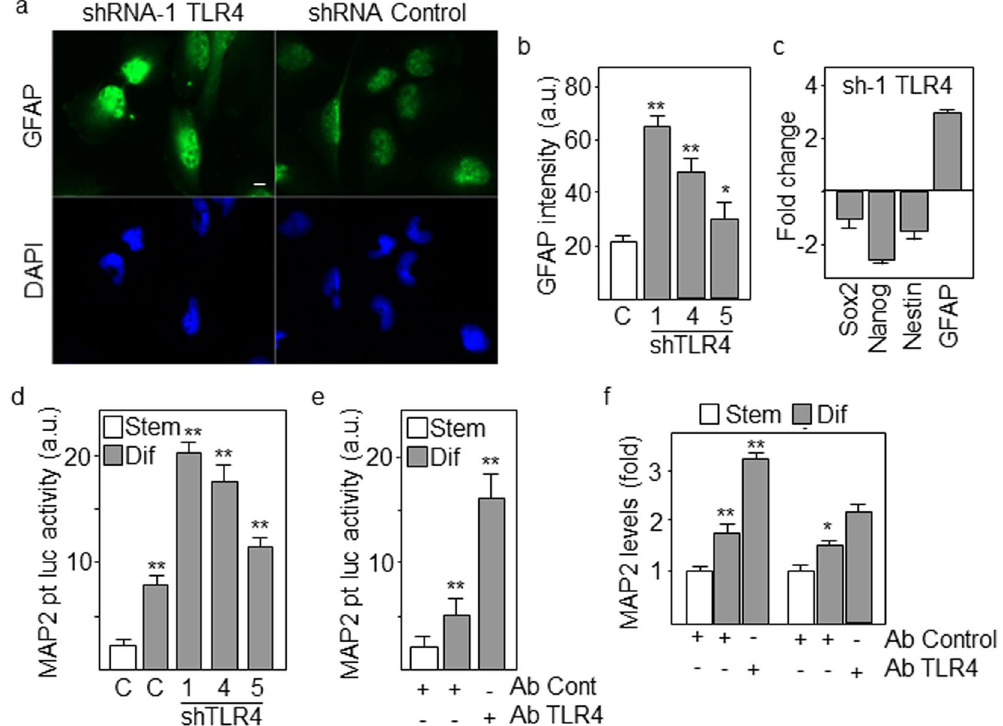
Figure 3. Downregulation of TLR4 accelerates differentiation of GSCs. ( a , b ) GSCs were transfected with the indicated TLR4-specific shRNAs and expression of GFAP after 8 days of differentiation was assessed by immunofluorescence. Fluorescence intensity was measured using ImageJ software. Scale bar: 20 μ m. ( c ) Cells were transfected with control or TLR4-specific shRNAs and differentiated for 8 days. The expression of progenitor (Nestin, Sox2, Nanog) and lineage (GFAP) markers was analyzed by qPCR. The expression levels were represented as fold changes of cells transfected with TLR4 shRNA compared with control cells. All markers showed significant differences (p < 0.01). ( d ) Transcriptional activity of the MAP2 promoter in stem and differentiating cells following transfection with three TLR4-specific shRNAs. ( e ) Transcriptional activity of the MAP2 promoter in cells treated with blocking anti-TLR4 antibodies. ( f ) Expression levels of MAP2 mRNA in stem and differentiating cells treated with blocking antibody. Histograms represent the mean ± SD of three independent experiments. Asterisks in grey bars represent significant differences ( * p < 0.05, ** p < 0.01) compared to empty (control) bars. a.u., arbitrary